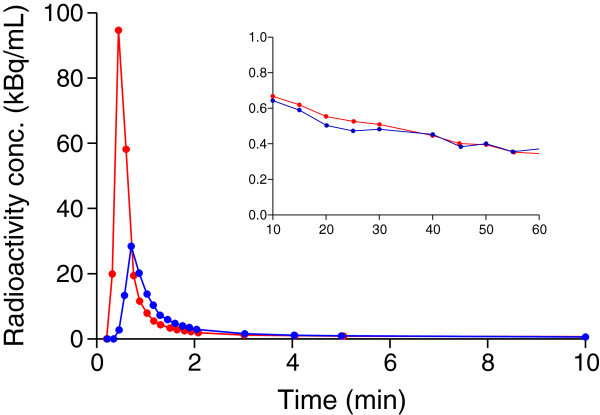
Plasma time-activity curve of [11C]befloxatone concentrations in arterial and venous blood for a representative subject. The main frame shows the first 10 min; the inset magnifies the remaining part of the input function. Red curve, arterial blood; blue curve, venous blood. The venous peak was predictably much lower than the arterial one, but [11C]befloxatone concentrations were remarkably similar immediately after the peak until the end of the scan. Although compartmental modeling cannot be used with a venous input due to the different shapes of the early part of the curves, the Logan graphical analysis only depends on the total area under the curve. For this subject, the VT error using only the venous input was 7.2% compared to the reference VT values obtained with the arterial input.